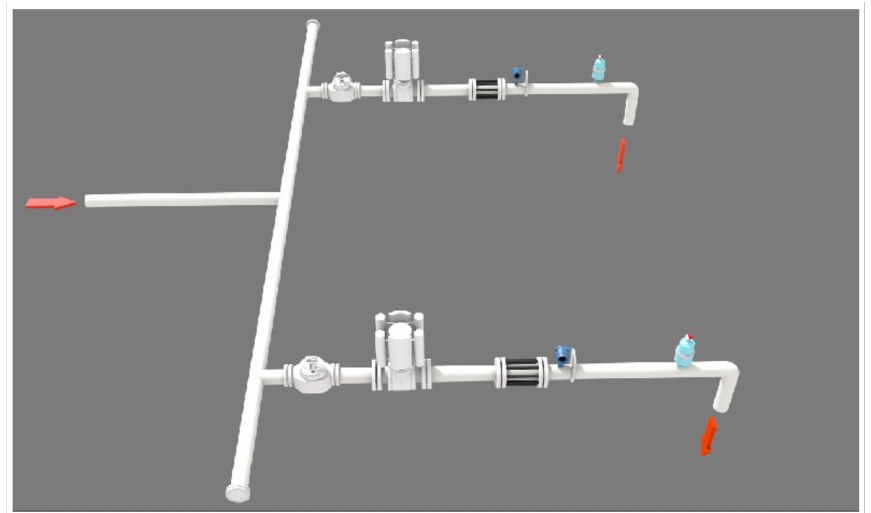
Figure 7. Cluster rendering